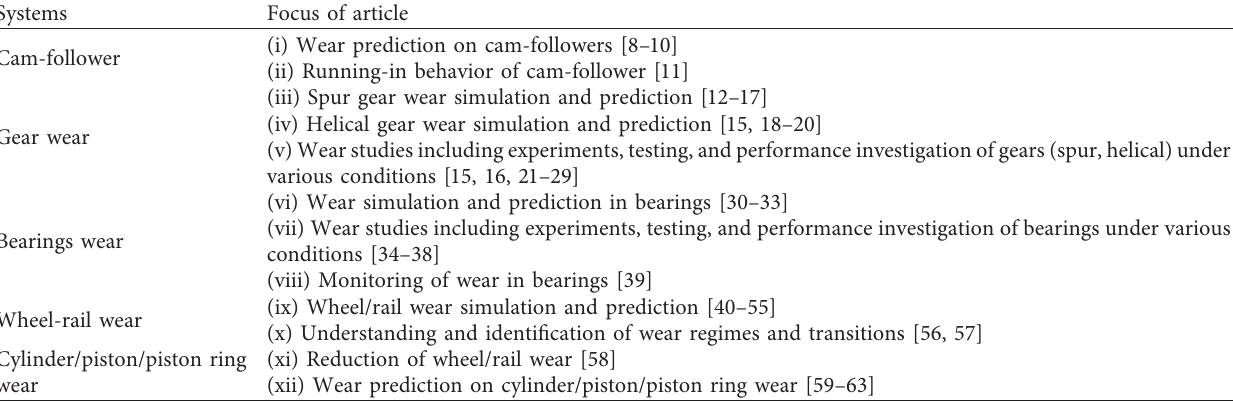
Table 1: Sample of wear studies on mechanical systems found in the